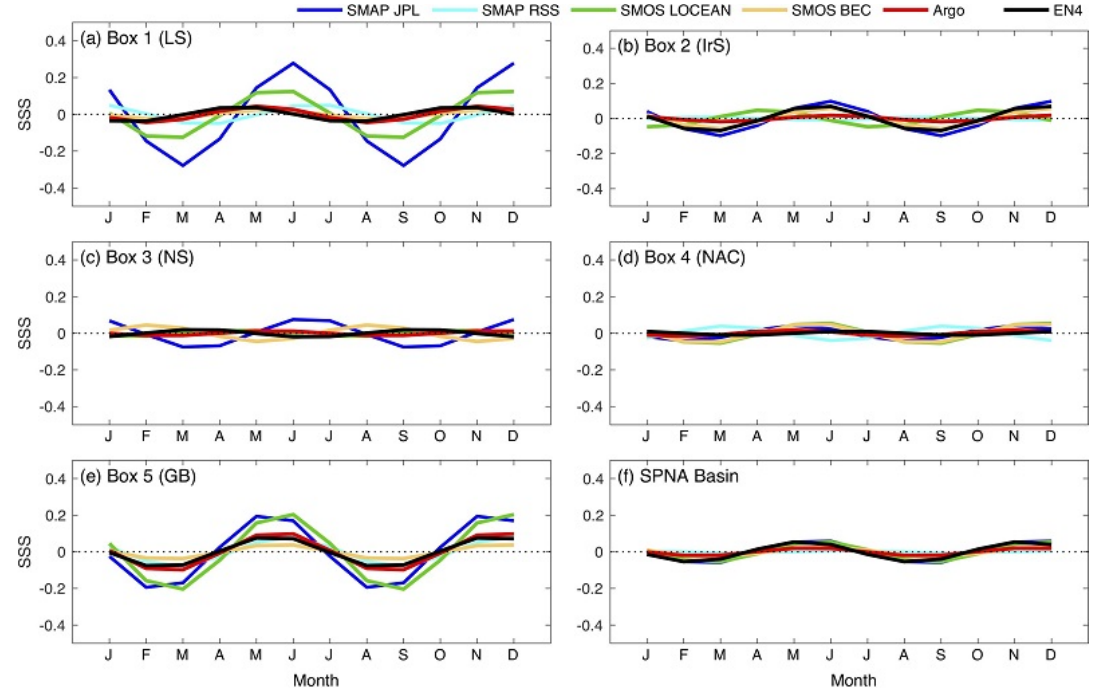
Figure 8. The the estimated semiannual cycles averaged over the five selected boxed areas depicted in Figure 1b and the entire basin. ( a ) Box 1. LS: The Labrador Sea. ( b ) Box 2. IS: The Irminger Sea. ( c ) Box 3. NS: The Nordic Seas. ( d ) Box 4. SPG: The Subpolar Gyre. ( e ) Box 5. NFL: Newfoundland. ( f ) The entire subpolar North Atlantic basin.